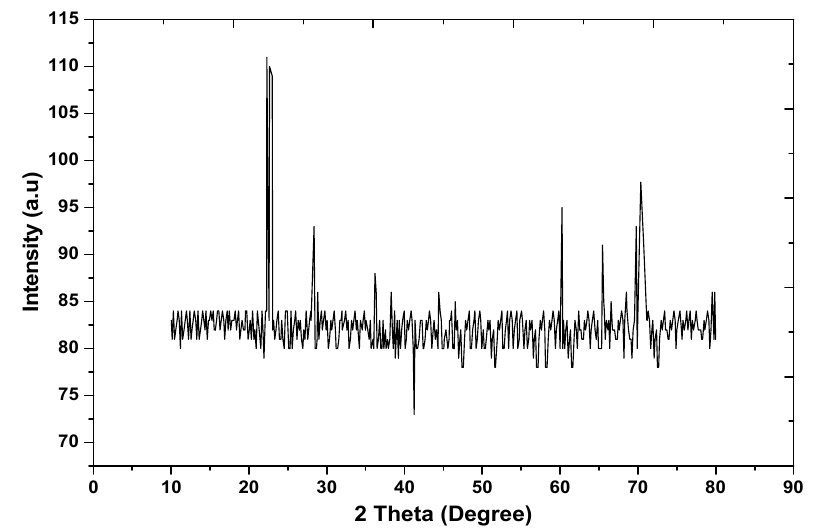
Figure 3. XRD pattern of the OPS nanoparticles.